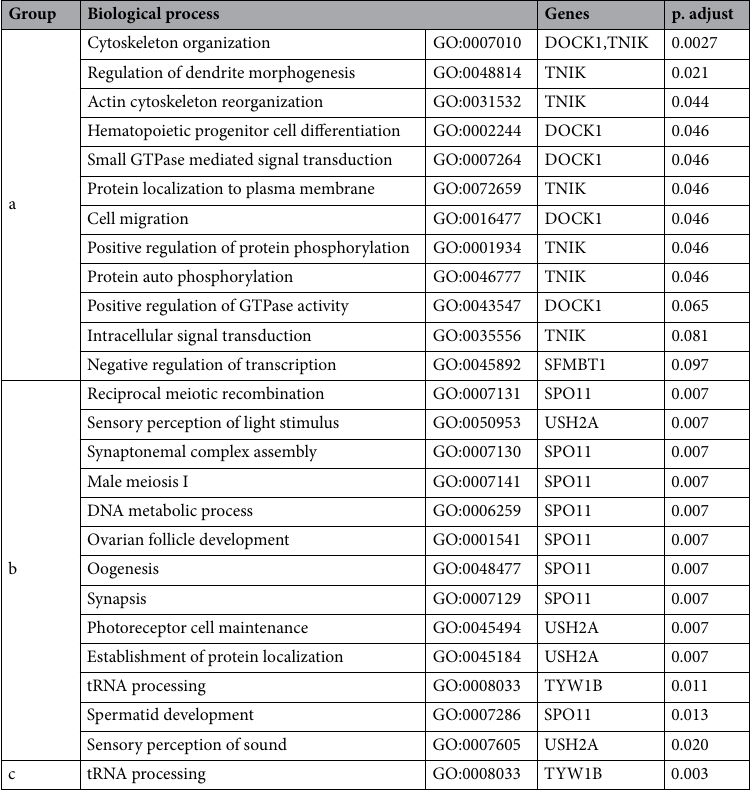
Table 2. Breed biological process of common candidate genes under selective pressure for F ST , Rsb, xp-EHH, and FLK tests on: (a) IR vs. IN, (b) IR vs. AF, (c) IN vs.